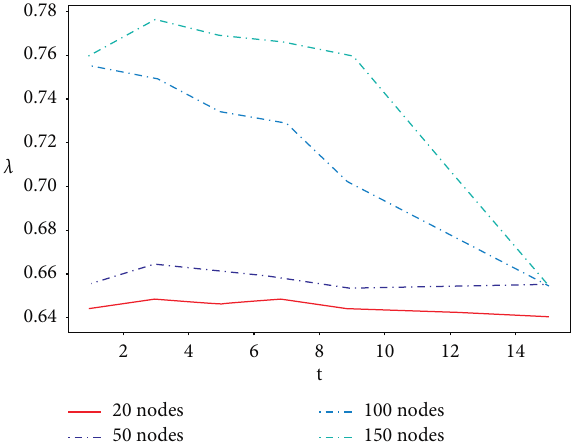
Figure 3: Effect diagram of different layers and nodes.